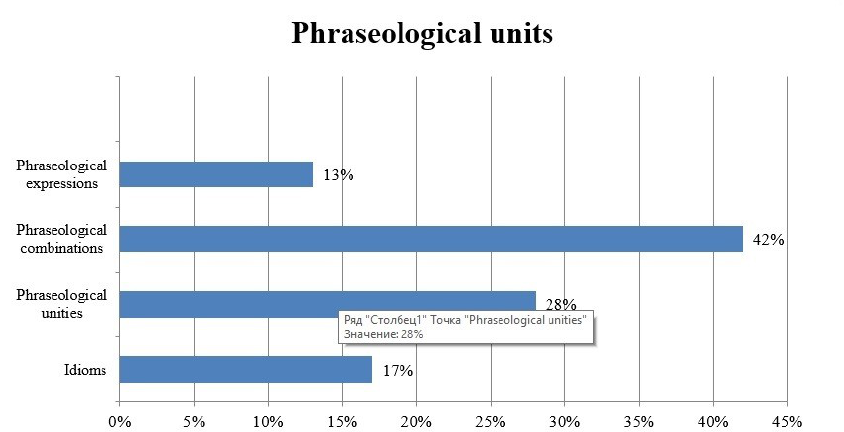
Figure 2 - Phraseological units to express negative evaluation in a sports report DOI: